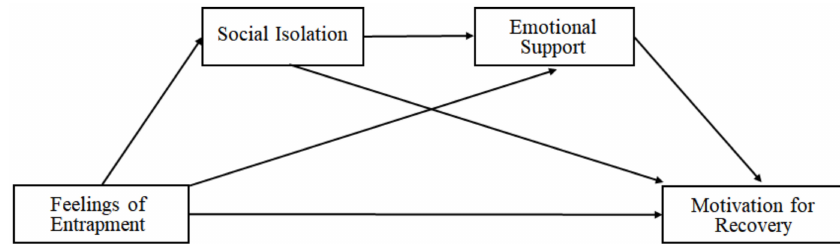
Figure 1. Double sequential mediation